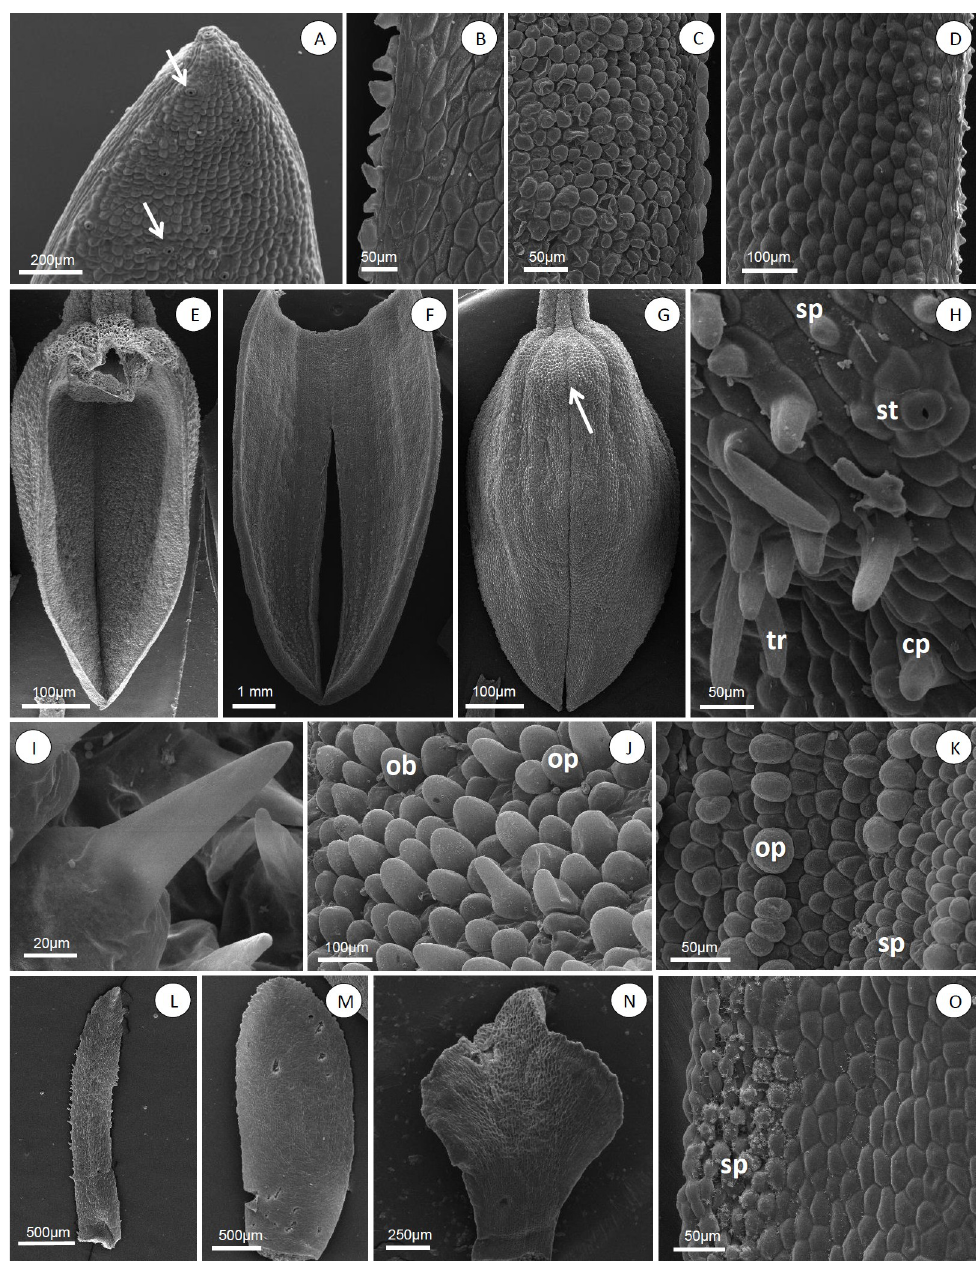
Acianthera crepiniana , ciliate entire margin. (C) Acianthera saundersiana , papillose entire margin. (D)